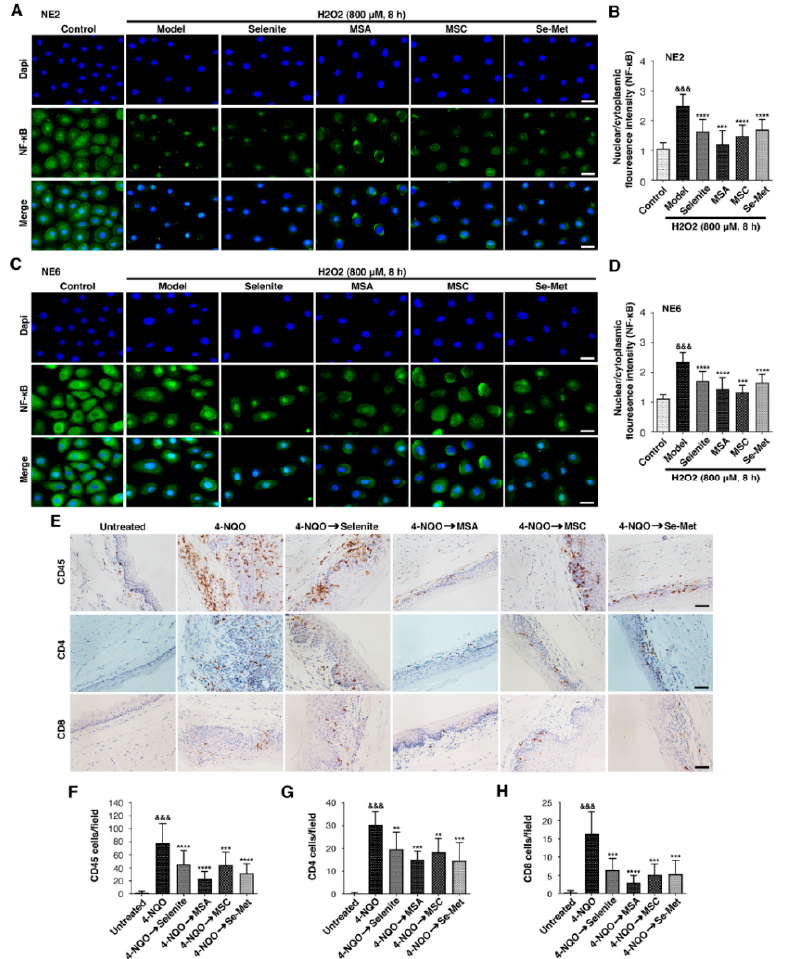
Figure 4. Selenium impedes inflammation in esophageal immortalized epithelial cell lines and 4-NQO mice model. Cells (NE2 and NE6) were pre-treated with selenium compounds, selenite (6 µ M), MSA (2 µ M), MSC (100 µ M), and Se-Met (100 µ M) for 2 h and then co-cultured with (800 µ M) H 2 O 2 for 8 h. NF- κ B expression was visualized by immunofluorescence using primary specific anti- bodies and Alexa Fluor 488-conjugated secondary antibodies. Nuclei were stained with DAPI. ( A ) Representative images of NF- κ B fluorescence in NE2 cell line. ( B ) The image analysis of NF- κ B flu- orescence data shows the nuclear to cytoplasmic staining ratio for each treatment in the NE2 cell line. ( C ) Representative images of NF- κ B fluorescence in NE6 cell line. ( D ) The image analysis of NF- κ B fluorescence data shows the nuclear to cytoplasmic staining ratio for each treatment in the NE6 cell line. The nuclear/cytoplasm fluorescence intensity per cell was determined by counting at least 100 cells on 10 fields randomly selected for each sample. Differences are significant at ( &&& p < 0.001 vs. untreated group, *** p < 0.001, **** p < 0.0001 vs. H 2 O 2 group, n ≥ 3). Data are expressed as mean ± SD from three ( n = 3) independent experiments. (Magnification, ×40; scale bar = 20 µm.) Selenium compounds, selenite (0.05 mg/kg), MSA (0.05 mg/kg), MSC (0.1 mg/kg), Se-Met (0.1 mg/kg) were administered for 4 weeks of post-completion and for 16 weeks of 4-NQO exposure. The mice were sacrificed, and the esophagus sections were fixed, embedded in paraffin, and sec- tioned. Then, the tissue sections were stained with CD45, CD8, and CD4 antibodies. Four to five representative areas of each esophagus section from each mouse were photographed and analyzed per group. ( E ) Representative immunohistochemical staining of CD45, CD4, and CD8 for each treat- ment group. ( F ) Numerical analysis of CD45-positive cells for each treatment group. ( G ) Numerical analysis of CD4-positive cells for each treatment group. ( H ) Numerical analysis of CD8 for each treatment group. Differences are significant at ( &&& p < 0.001 vs. untreated group, ** p < 0.01, *** p < 0.001, **** p < 0.0001 vs. 4-NQO group). A difference with p ≤ 0.05 was considered statistically sig- nificant. (Magnification, ×400; scale bar = 40 µm.)